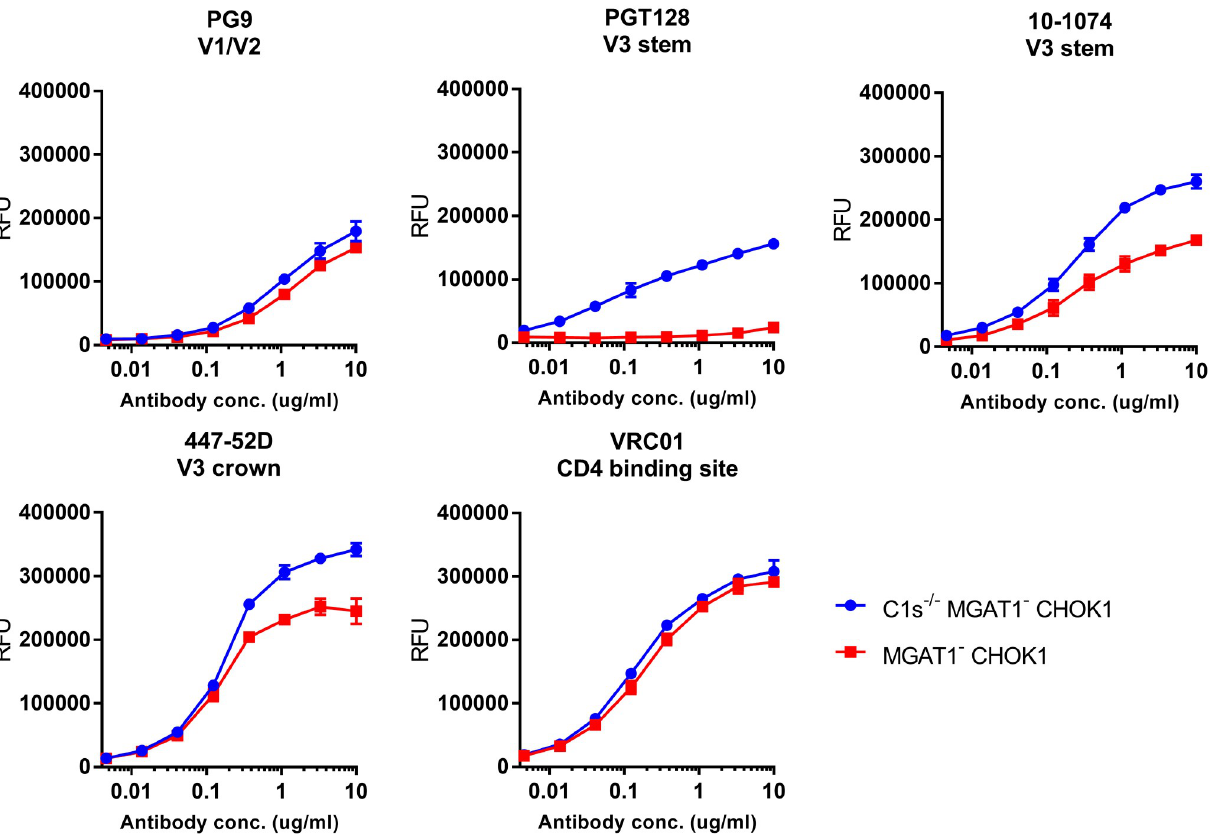
Fig 5. Effect of proteolysis by C1s on the binding of neutralizing monoclonal antibodies and broadly neutralizing monoclonal antibodies to EN6 rgp120. Plasmids encoding EN6 rgp120 were transiently expressed in the C1s -/- MGAT1 - CHOK1 1.A1 and MGAT1 - CHOK1 cell lines. Growth- conditioned cell culture supernatants were diluted for a 34.1 mAb capture FIA. All assays were performed in triplicate. Indicated under the antibody names are the epitope recognized by the respective antibodies.